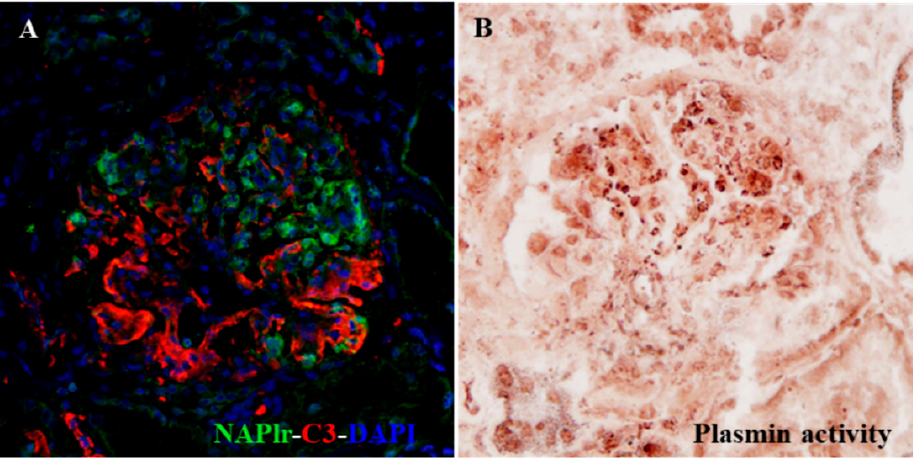
Figure 3. Photomicrographs of histological staining for C3, NAPlr, and plasmin activity in the glomeruli of a patient with infection-related glomerulonephritis (IRGN) induced by asymptomatic sinusitis [36]. Although the infection was clinically inapparent, double IF staining for NAPlr (fluo- rescein isothiocyanate, green) and C3 (Alexa Fluor 594, red) with nuclear staining for DAPI (blue) showed glomerular deposition of NAPlr and C3 ( A ). Furthermore, glomerular plasmin activity assessed by in situ zymography on a serial section demonstrated a similar distribution as NAPlr deposition, providing histological evidence for the substantial involvement of bacterial infection in the development of glomerulonephritis ( B ).